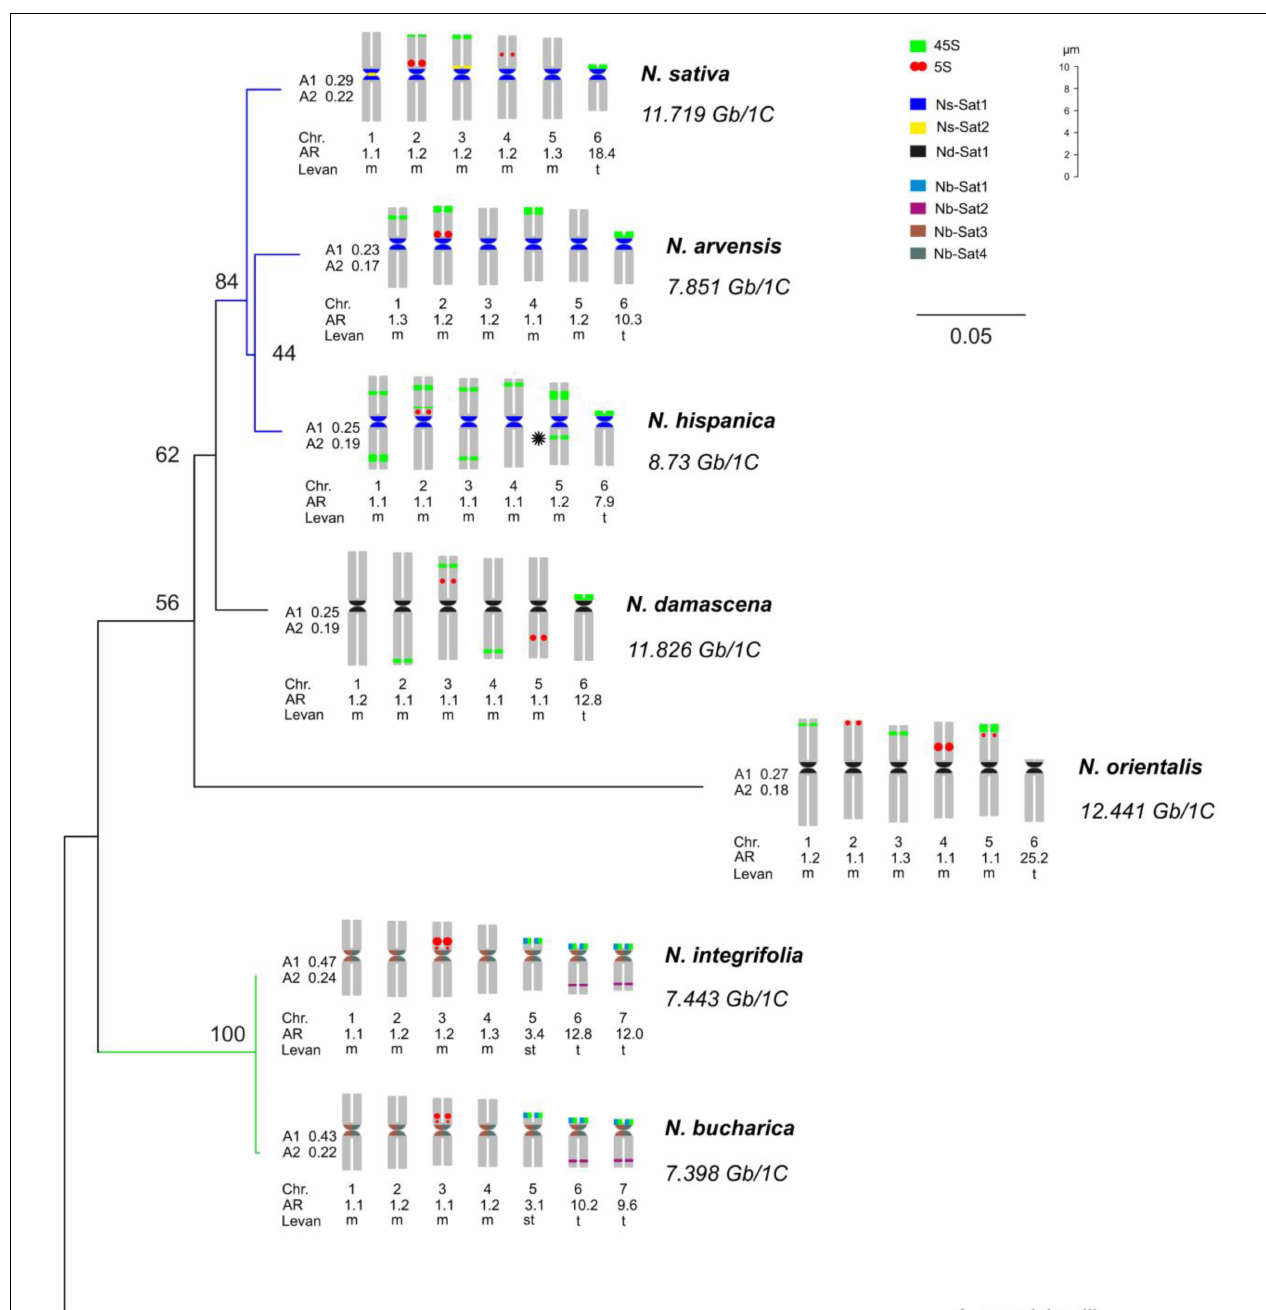
FIGURE 1 | Phylogeny and idiograms of Nigella . A maximum likelihood phylogenetic tree of Nigella species with 500 bootstrap replications inferred from ITS1-5.8S-ITS2 and rbc L sequences. A. carmichaelii has been included as an outgroup. The tree has been annotated with idiograms (showing the locations of the identified satellite repeats and 45S and 5S arrays), karyotypic parameters and the estimated DNA C-values. The asterisk in N. hispanica indicates the hemizygous locus. Chr.: Chromosome; A1: intrachromosomal asymmetry index; and A2: interchromosomal asymmetry index; Levan: the description of chromosome morphology was based on the nomenclature proposed by Levan et al. (1964), AR: arm ratio (long arm/short arm).